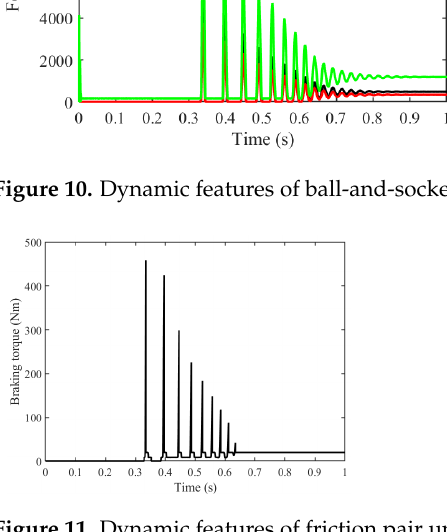
Figure 12. Dynamic features of output shaft under reverse load. ( a ) Angular velocity. ( b ) Angular displacement.